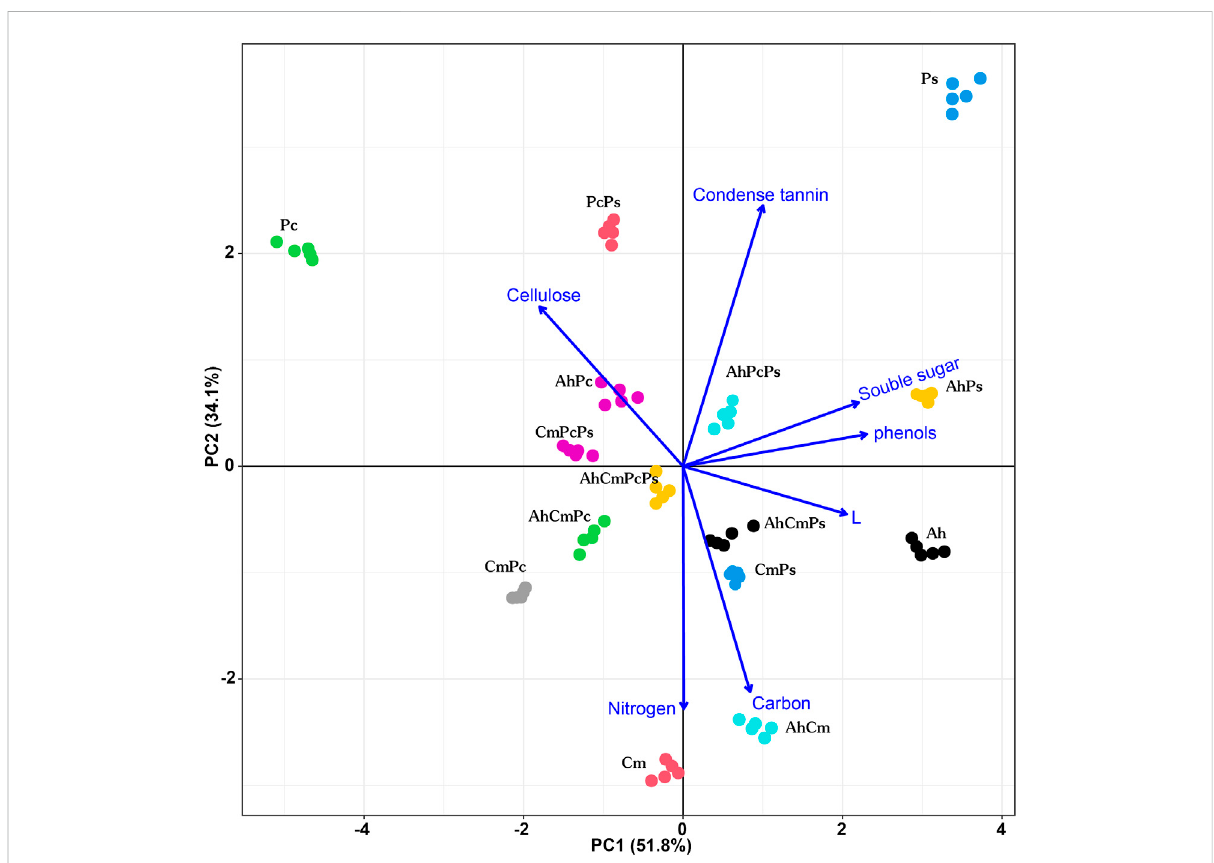
FIGURE 1 Principal components plot of litter quality index measured for Artemisia halodendron (Ah), Caragana microphylla (Cm), Pennisetum centrasiatium (Pc), and Populus simonii (Ps), Artemisia halodendron+ Caragana microphylla (AhCm), Artemisia halodendron+ Pennisetum centrasiatium (AhPc), Artemisia halodendron+ Populus simonii (AhPs), Caragana microphylla+ Pennisetum centrasiatium (CmPc),